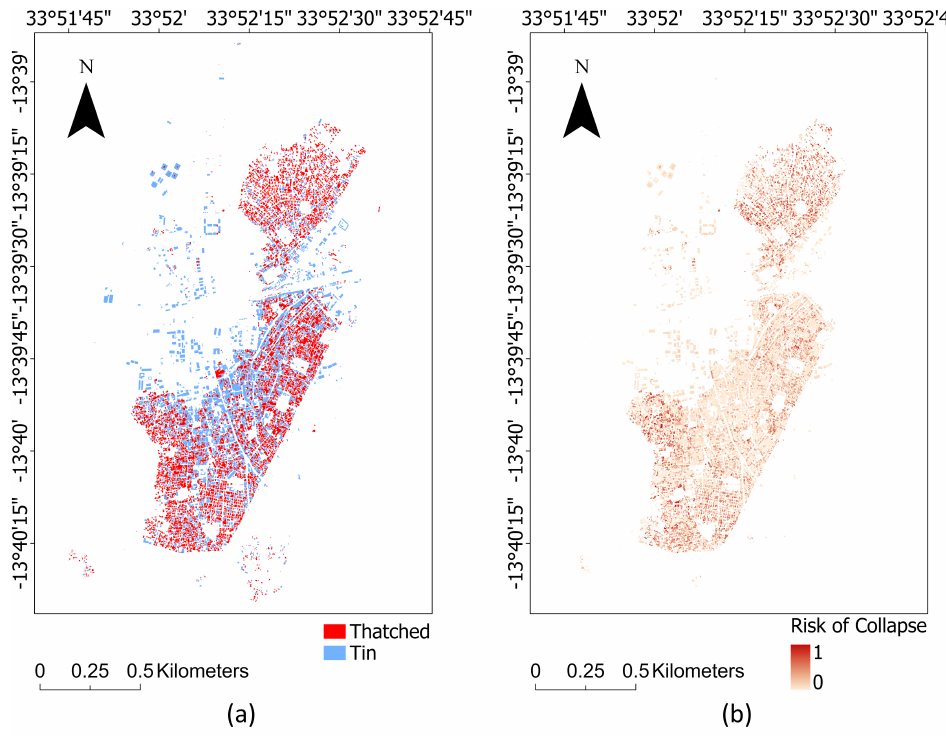
Figure 19. ( a ) Picterra found buildings classified as thatched (red) or tin (blue); ( b ) Building risk map normalized from 0 (white) to 1 (red), where 1 are locations of highest risk.